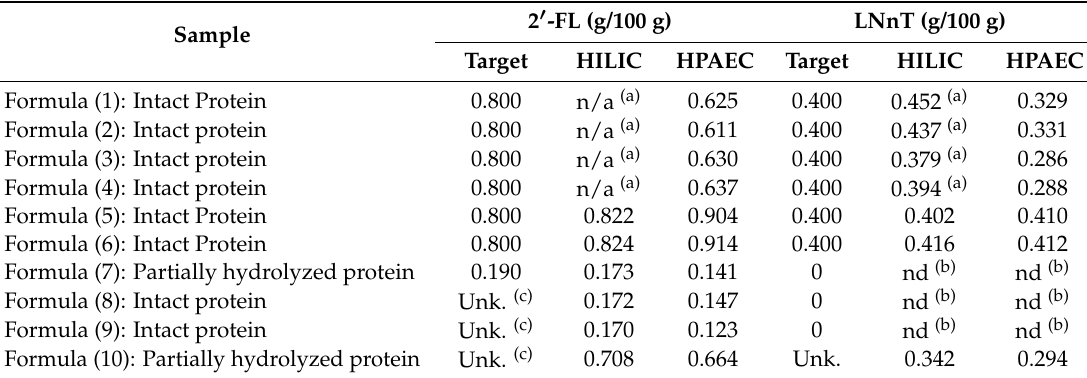
Table 3. Determination of HMO in pilot plant or commercial